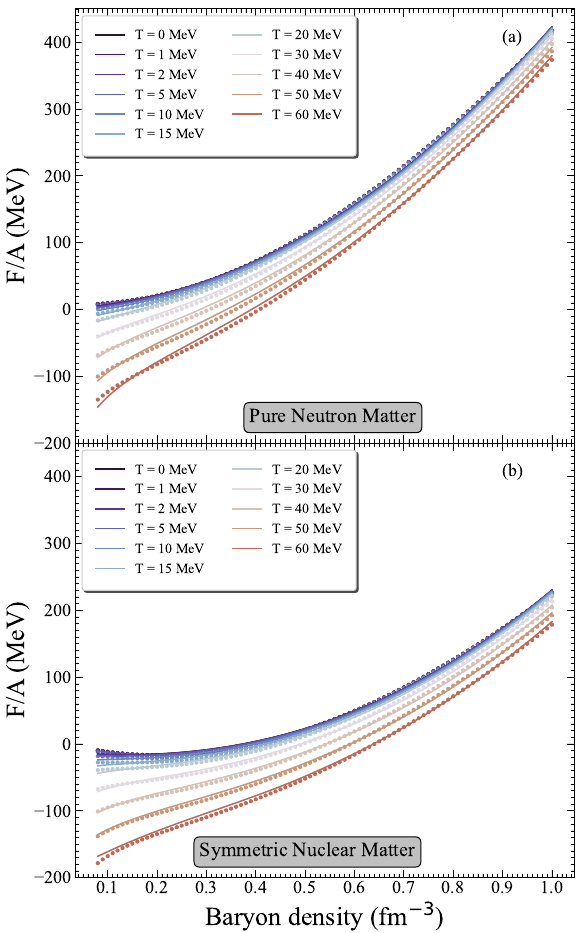
Figure 2. The free energy per particle as a function of the baryon density for (a) PNM and (b) SNM and temperatures in the range [0 , 60] MeV. Fits are presented with the solid lines and data with circles (see also Ref.